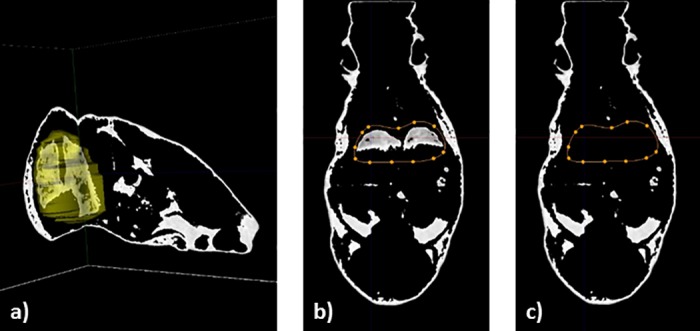
The different steps for lung manual correction on fat volumes on micro-computed tomography scans.Micro-CT scans were performed in 10 mice, with and without respiratory-gated conditions, on the same field of view (thoracic region). (a) 3D representation of the region of interest around the lungs. (b) One slice of representation of total adipose tissue with lung selection through a region of interest (in orange dotted line). (c) Suppression of lung region on the same slice.